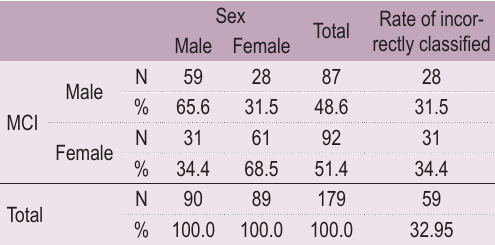
Std. MCI =0.244; MCI: Mandibular Canine Index (index of lower canines); N: Number of samples; Std. MCI: Standard Mandibular Canine Index (Standard index of lower canines)